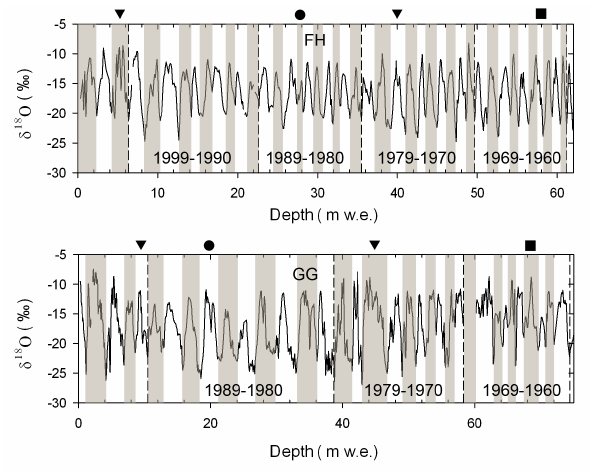
Figure 2. δ 18 O raw data from Fiescherhorn core drilled in 2002 (FH, top panel, first 60mw.e. corresponding to the period 1961– 2001), and Grenzgletscher (GG, bottom panel, first 70mw.e., cor- responding to the period 1961–1993, with a gap in the period 1968– 1970). White and grey alternating bars show the different annual layers. The reference horizons used for the dating are indicated as follows. Triangles: Saharan dust events (2000, 1990, 1977).